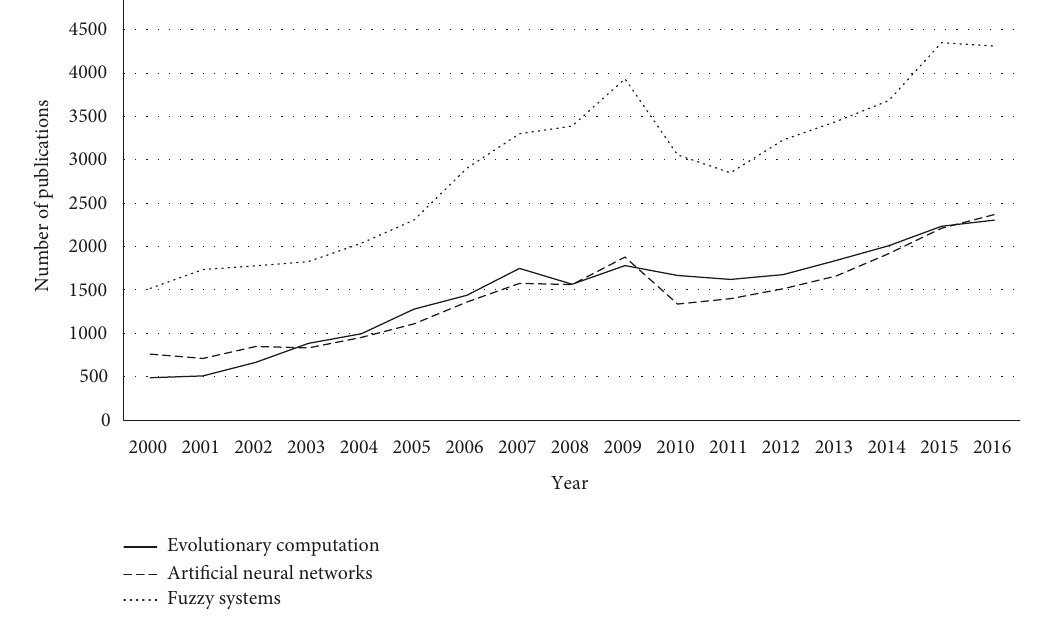
Figure 5: Publications of the main topics of computational